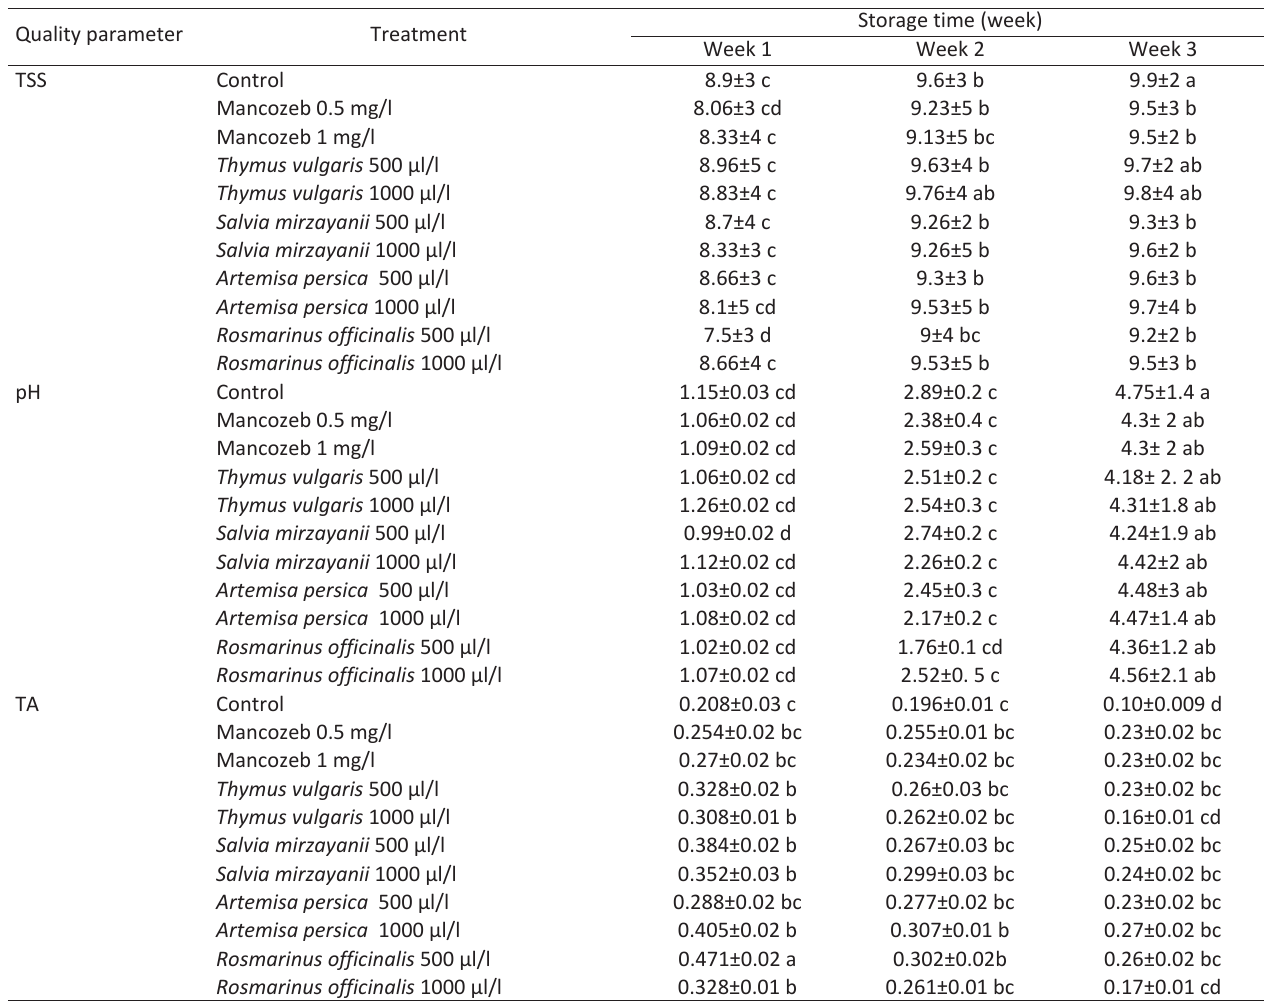
Table 3 - Effect of the Thymus vulgaris , Salvia mirzayanii , Artemisia persica and Rosmarinus officinalis EOs tested at 500 and 1000 μl/l on Total Soluble Solids (TSS), pH, and Titratable Acidity (TA) ± SD in mangos after 1, 2, and 3 weeks of incubation compared to ‘mancozed’ (0.5 and 1.0 mg/l)